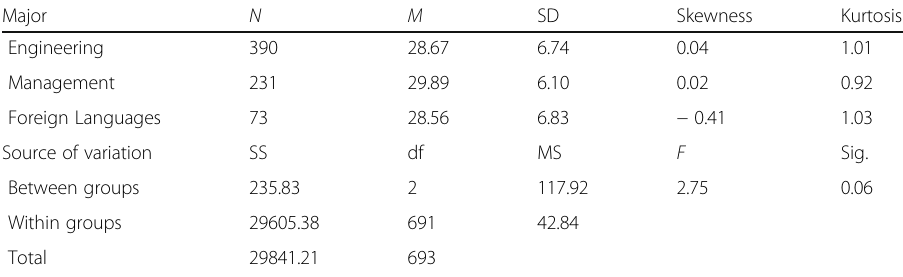
Table 5 Results of the one-way ANOVA comparing the mean difference in the strength of washback experienced among different majors Major N M